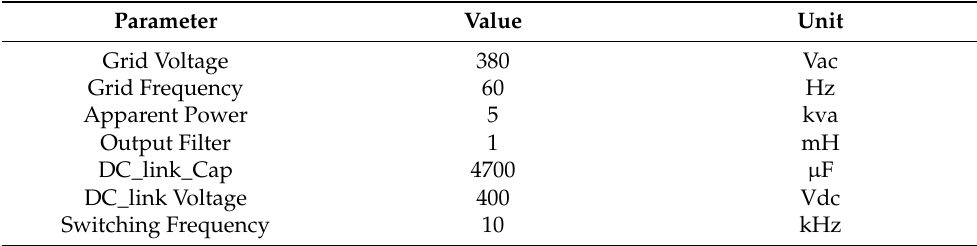
Figure 15. Active/reactive power control simulator for grid-connected devices. Table 1. Three-phase system parameters.